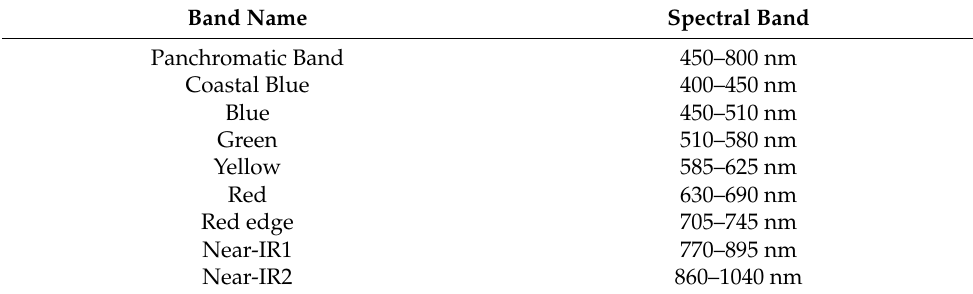
Table 1. Worldview3 sensor bands with corresponding